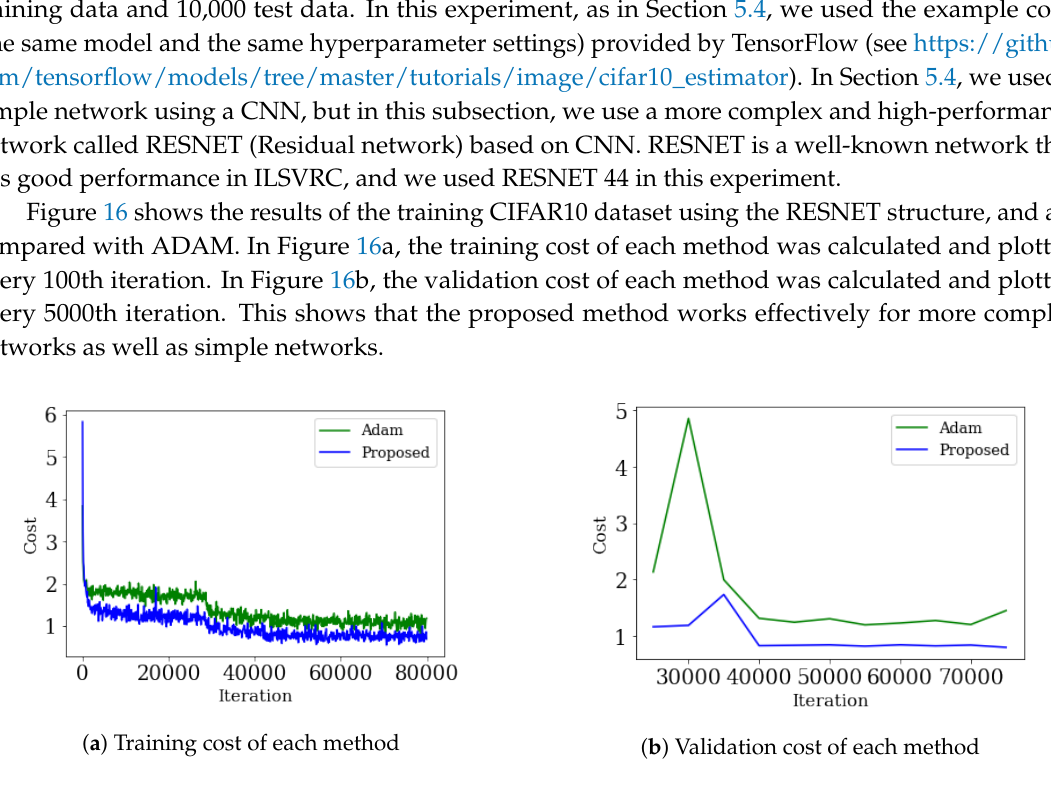
Figure 16. Result of CIFAR10 dataset using the RESNET 44 model. The following parameters are default values; iteration : 80000, batch size : 128, weight decay : 2 × 10 − 4 , learning rate : 0.1, batch norm decay :